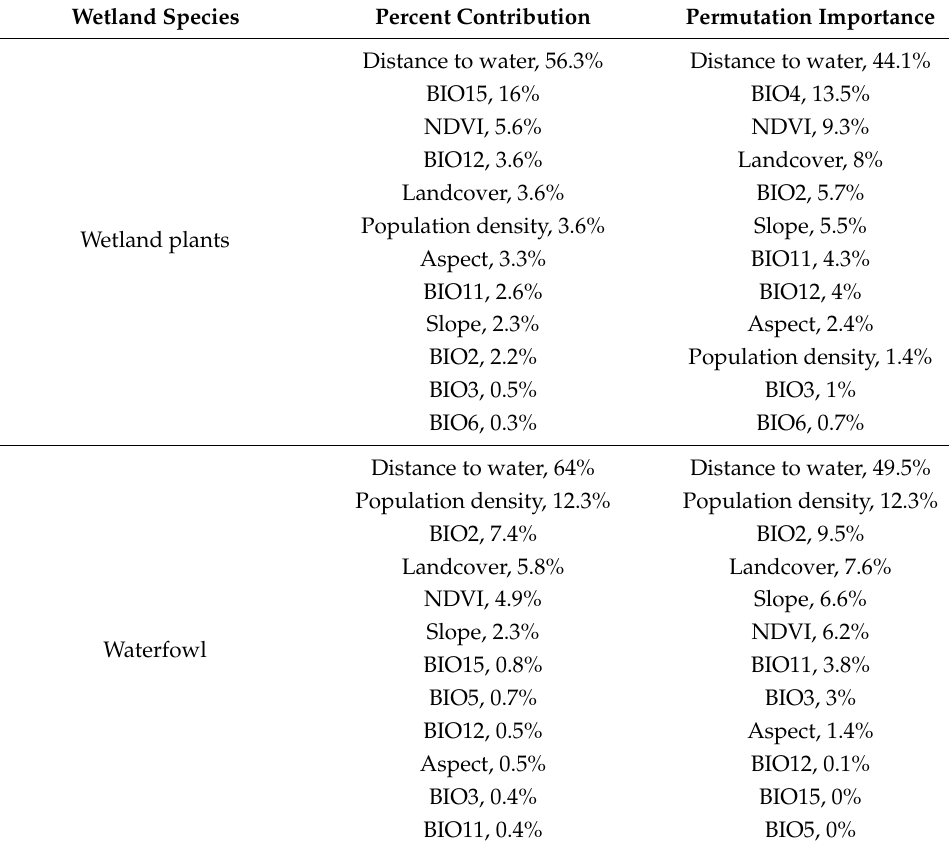
Table 3. Analysis of the variable contributions. Wetland